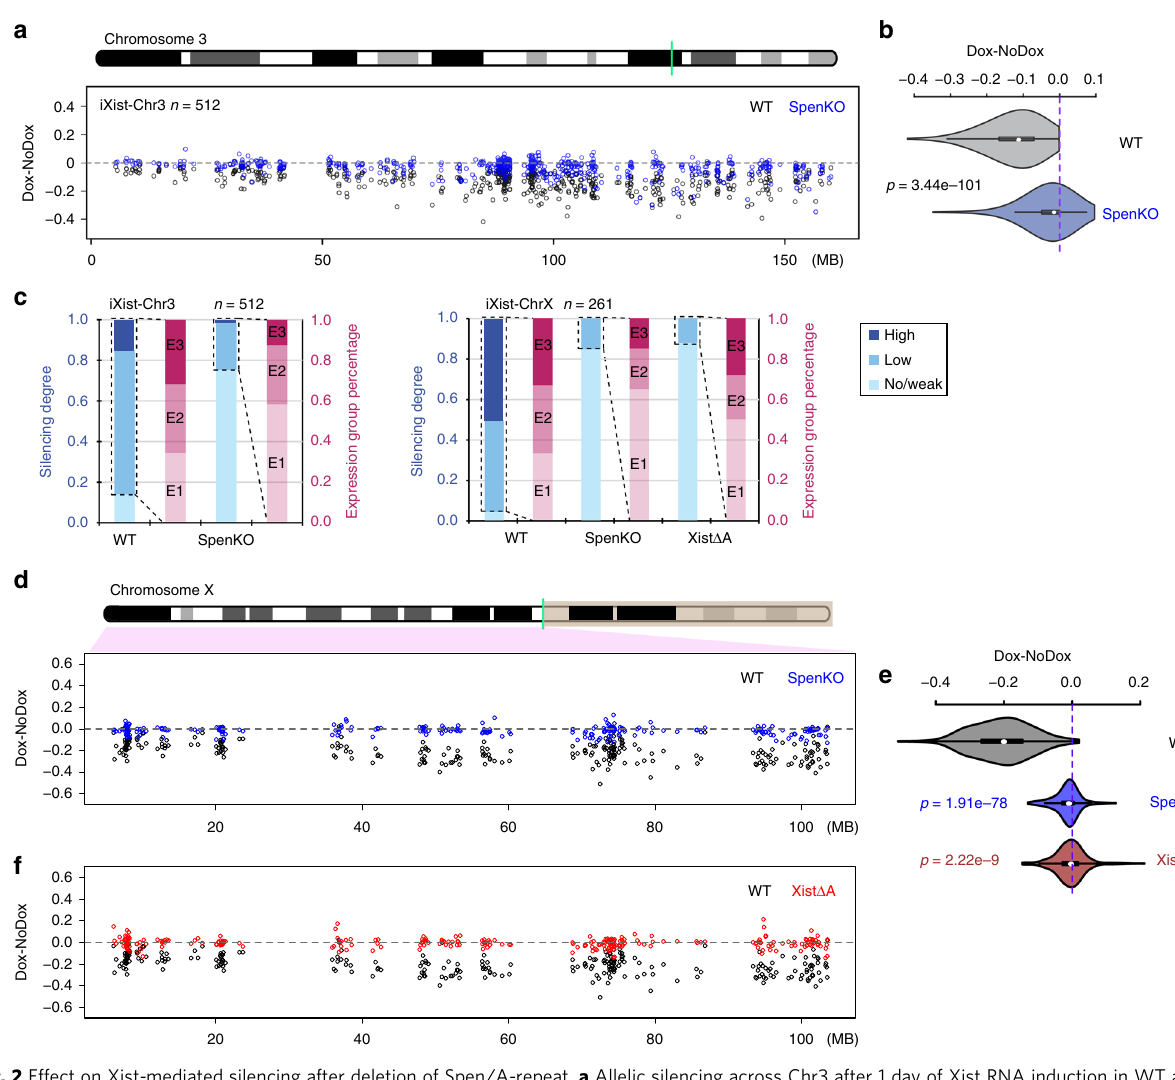
Fig. 2 Effect on Xist-mediated silencing after deletion of Spen/A-repeat. a Allelic silencing across Chr3 after 1 day of Xist RNA induction in WT and Spen null (KO) iXist-Chr3 cells. Mean value of difference of allelic ratio for each gene with an informative SNP was calculated from biological replicates as detailed in Supplementary Table 4. Green line on Chr3 ideogram indicates location of Xist transgene. b Violin plot summarising data in a , p values were calculated using one-sided Wilcoxon rank-sum test. c Distribution of genes by silencing degree in relation to mESC expression levels (three equal